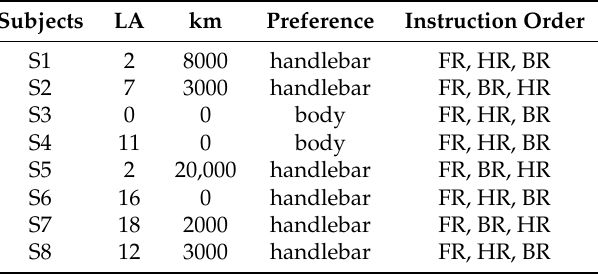
Table 2. Subjects’ declarative data.